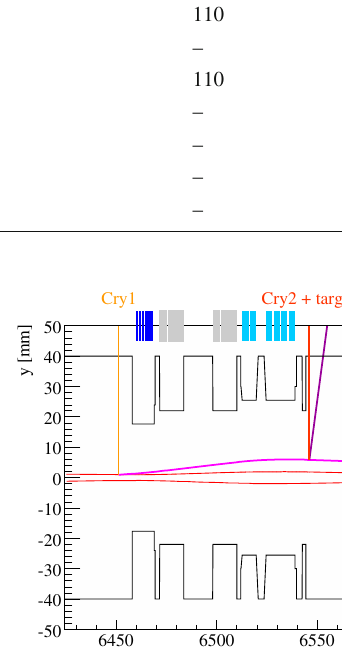
Fig. 3 ProposedexperimentallayoutinIR3.SamenotationasinFig.2. Normal conducting quadrupoles and dipoles are shown by the light blue and gray boxes, respectively